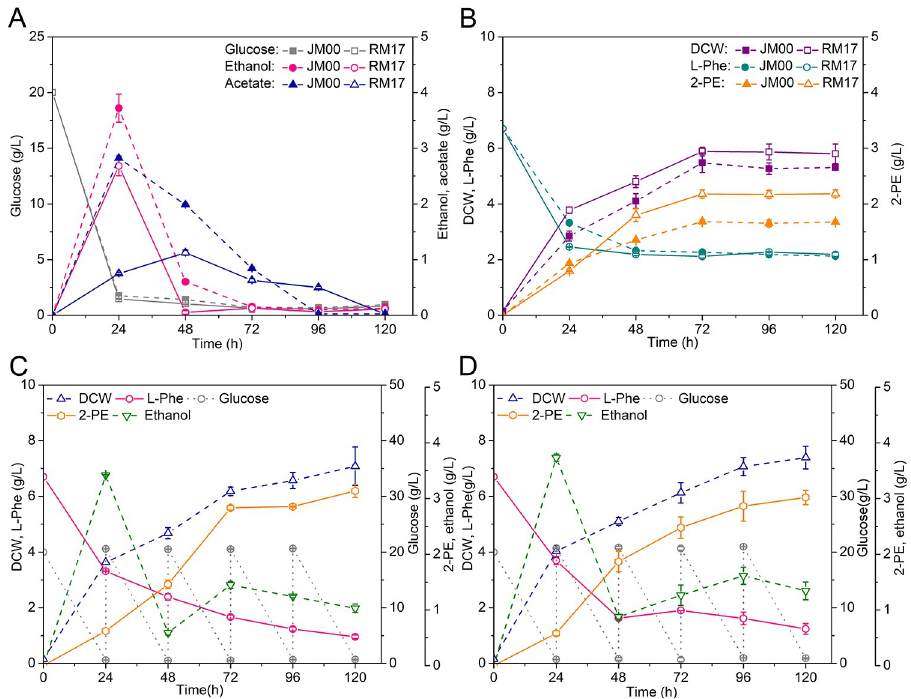
Fig 5. Influence on 2-PE production by fusion-expressing mutant strains. (A) Glucose consumption, ethanol and acetate of JM00 and RM17 (WT-A P TPI -ectyrB-llkdcA-scADH2 ) in YSM medium. (B) Cell growth, 2-PE titers and L- phenylalanine consumption of JM00 and RM17 in YSM medium. (C) Fermentation view of RM17 in YSM medium with the addition of 20 g/L glucose every 24 h. (D) Fermentation view of RM812 (WT-A P TPI - scARO8-scARO10-scADH2 ) in YSM medium with the addition of 20 g/L glucose every 24 h. Data are presented as the averages of the results of three independent experiments. Error bars show standard deviations.